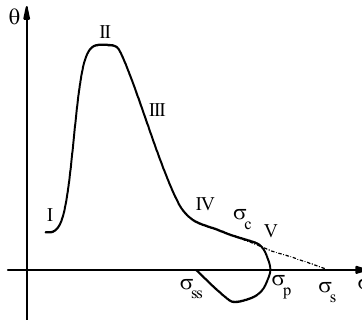
Figure 7. Schematic of the work ‐ hardening rate versus flow stress [22].